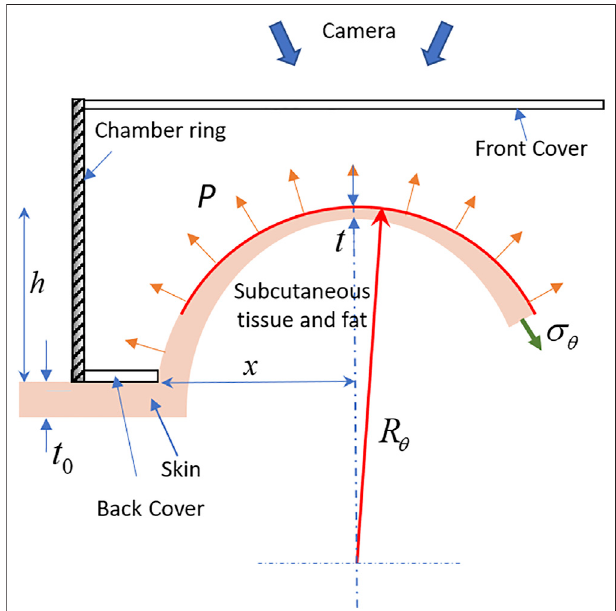
FIGURE 2| Aschematic diagram ofthe front cross-sectionalviewof the specimen deformation illustrates the thickness variation near the apex and deformed geometry of the